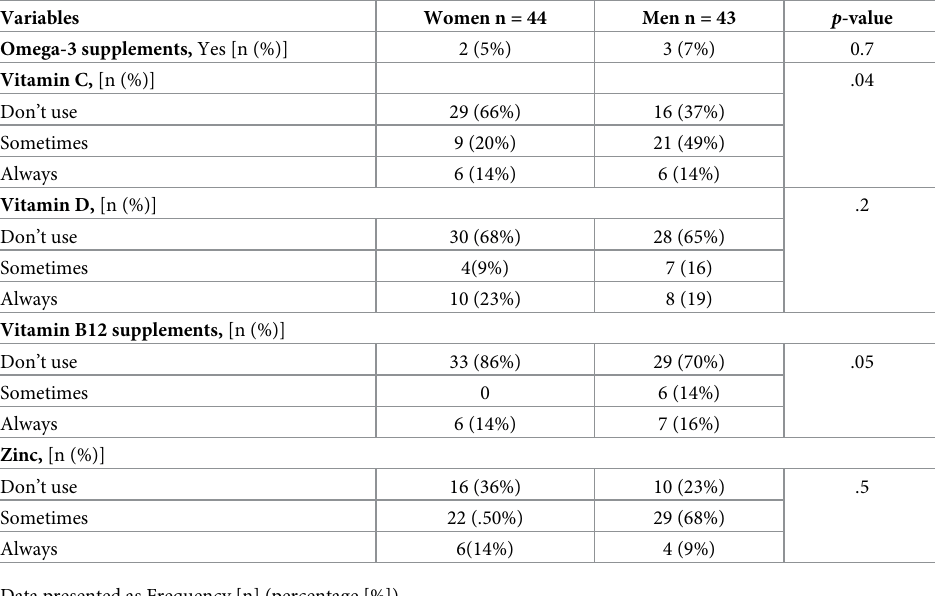
Table 2. Gender-based comparison of vitamin and dietary supplement. Variables Women n =